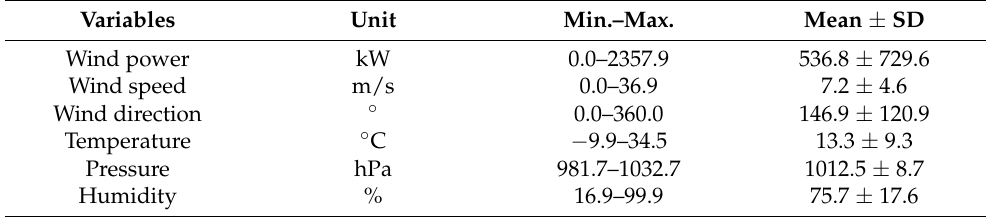
Figure 1. Location of Yeonggwang Baeksu wind farm. Table 1. Statistical summary of weather information.